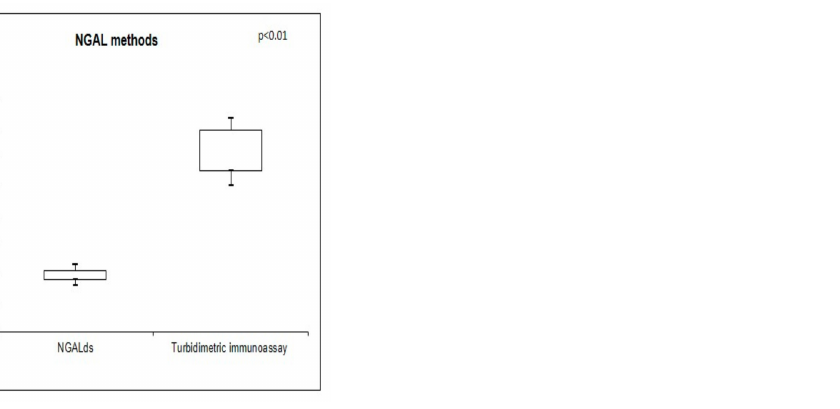
Figure 2. Comparison between NGALds assay and laboratory-based NGAL (turbidimetric im- munoassay) in terms of time. Thirty (=total number of patients enrolled in the study) determinations for each